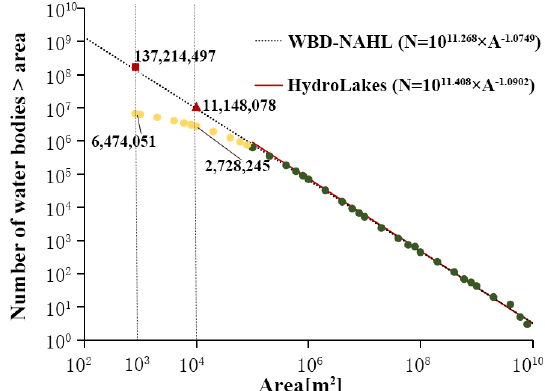
Figure 11. Distribution of the total numbers of water bodies in re- lation to the area of North American tundra and boreal forests water bodies. The circles represent the number of water bodies provided by WBD-NAHL. The black line is the power-law distribution mod- eled using water bodies > 0 . 1km 2 from WBD-NAHL. The red line is the power-law distribution modeled using HydroLAKES in the study region. The red triangle and square represent, respectively, the extrapolated number of water bodies > 0 . 01 and > 0 . 001km 2 based on the power-law distribution modeled from